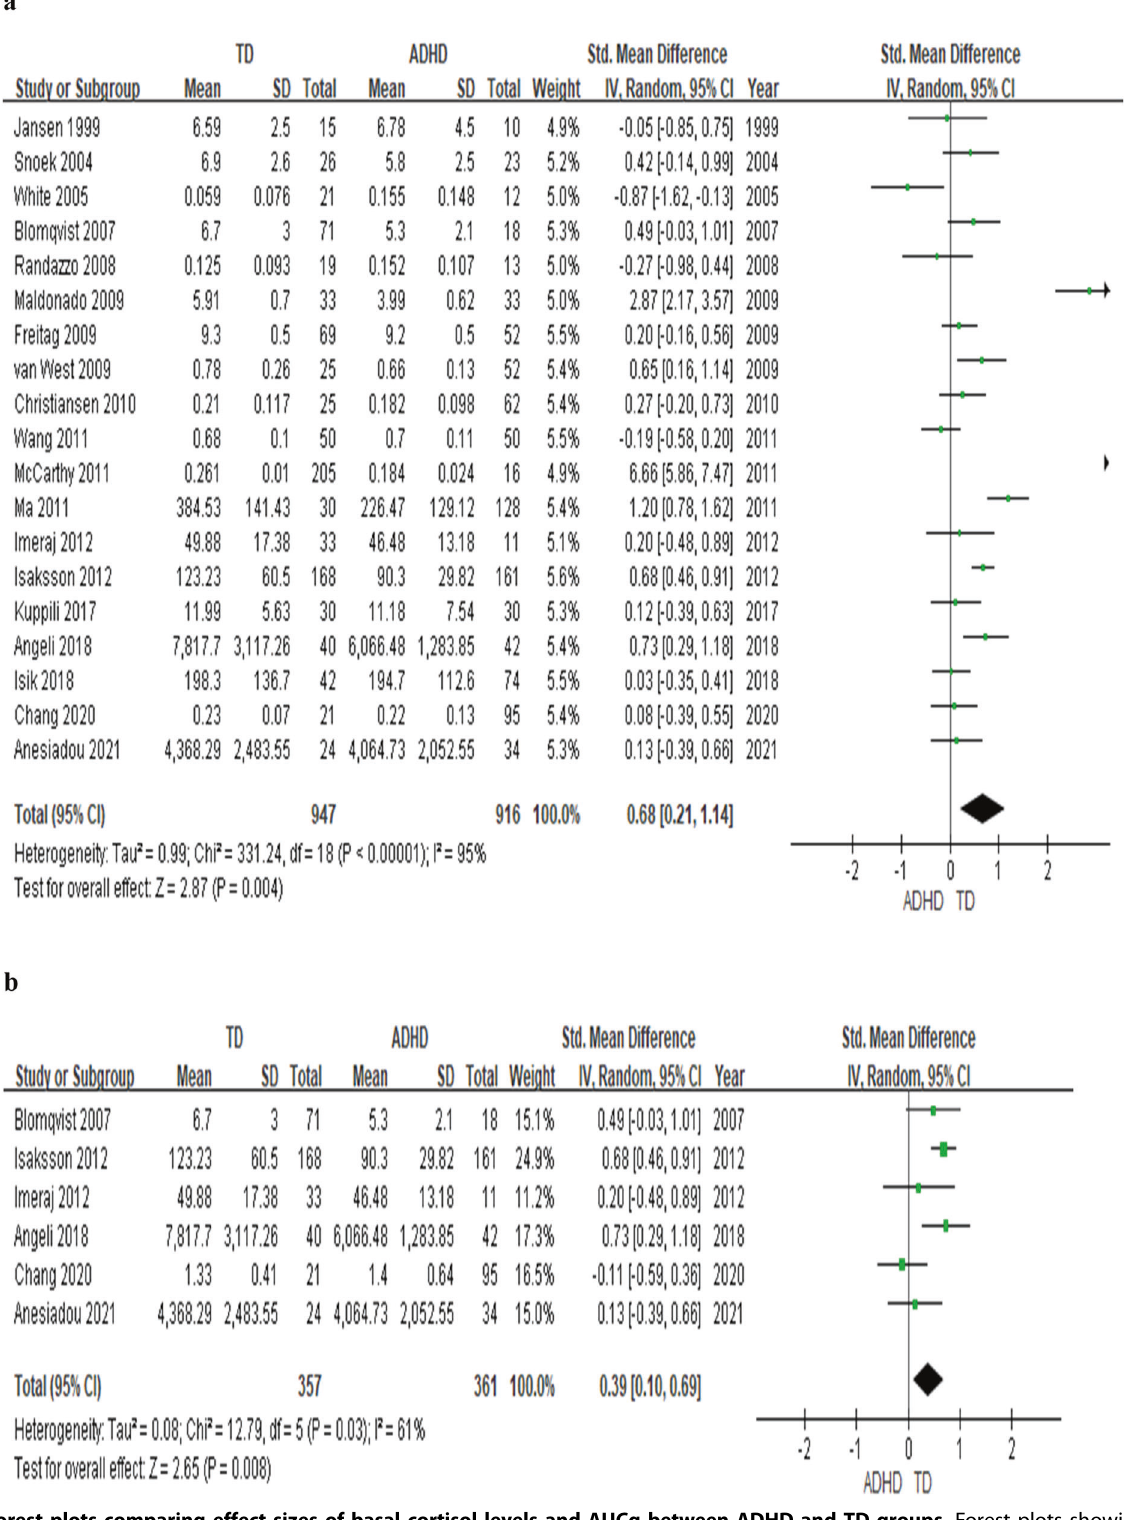
Fig. 1 Forest plots comparing effect sizes of basal cortisol levels and AUCg between ADHD and TD groups. Forest plots showing effect sizes (Hedges ’ s g) and 95% con fi dence intervals (CIs) from individual studies and pooled results comparing ( a ) cortisol levels at any time point throughout the day and ( b ) cortisol AUCg between ADHD population and TD group. Note, ADHD attention de fi cit hyperactivity disorder, AUCg area-under-the-curve with respect to the ground, CI con fi dence interval, Std standard, TD typically developing